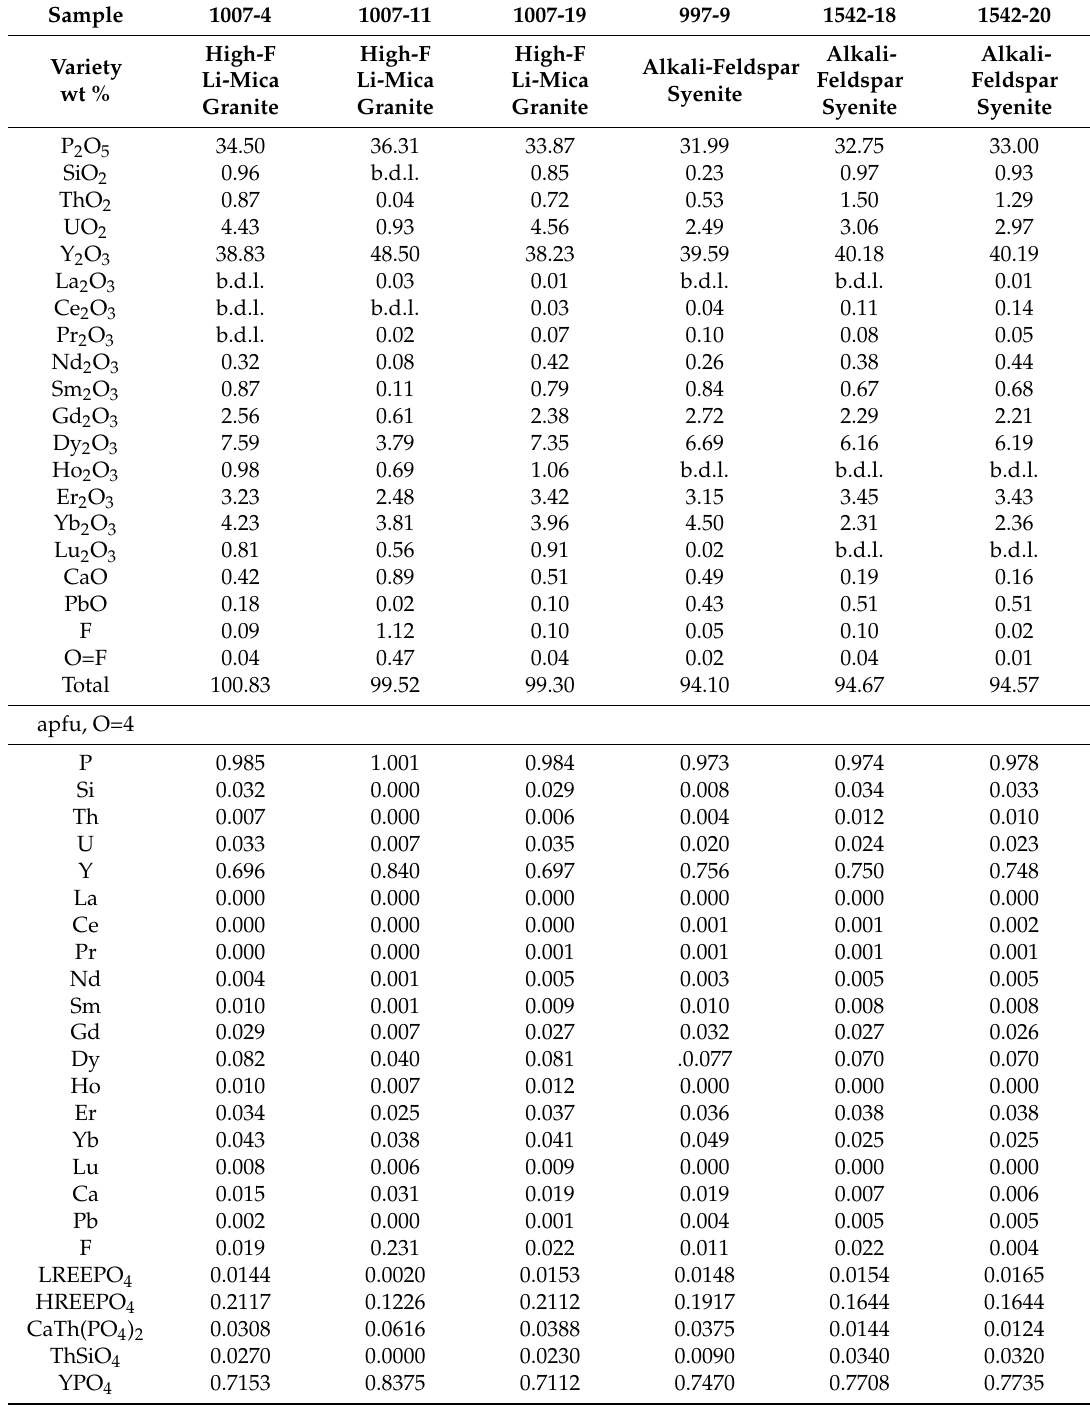
Table 3. Representative EPMA of